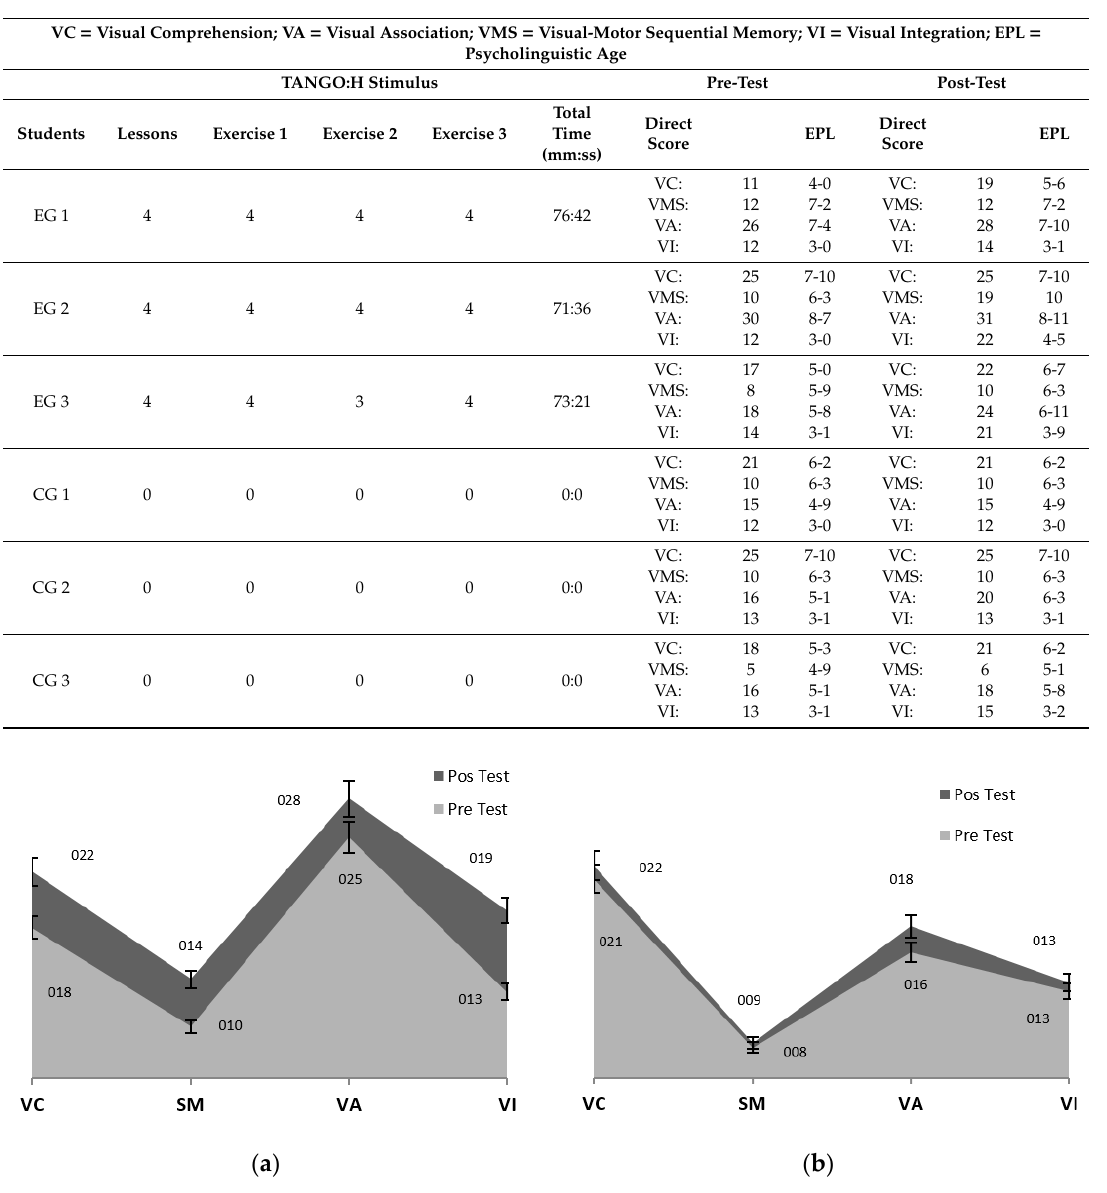
Table 4. Summary of results ITPA in EG and CG.